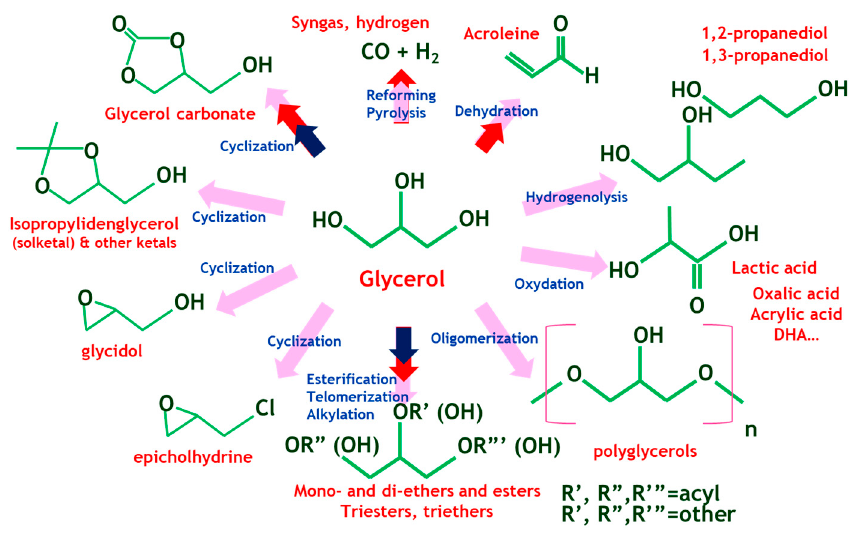
Figure 1. Several catalytic routes from glycerol (adapted from [19]).